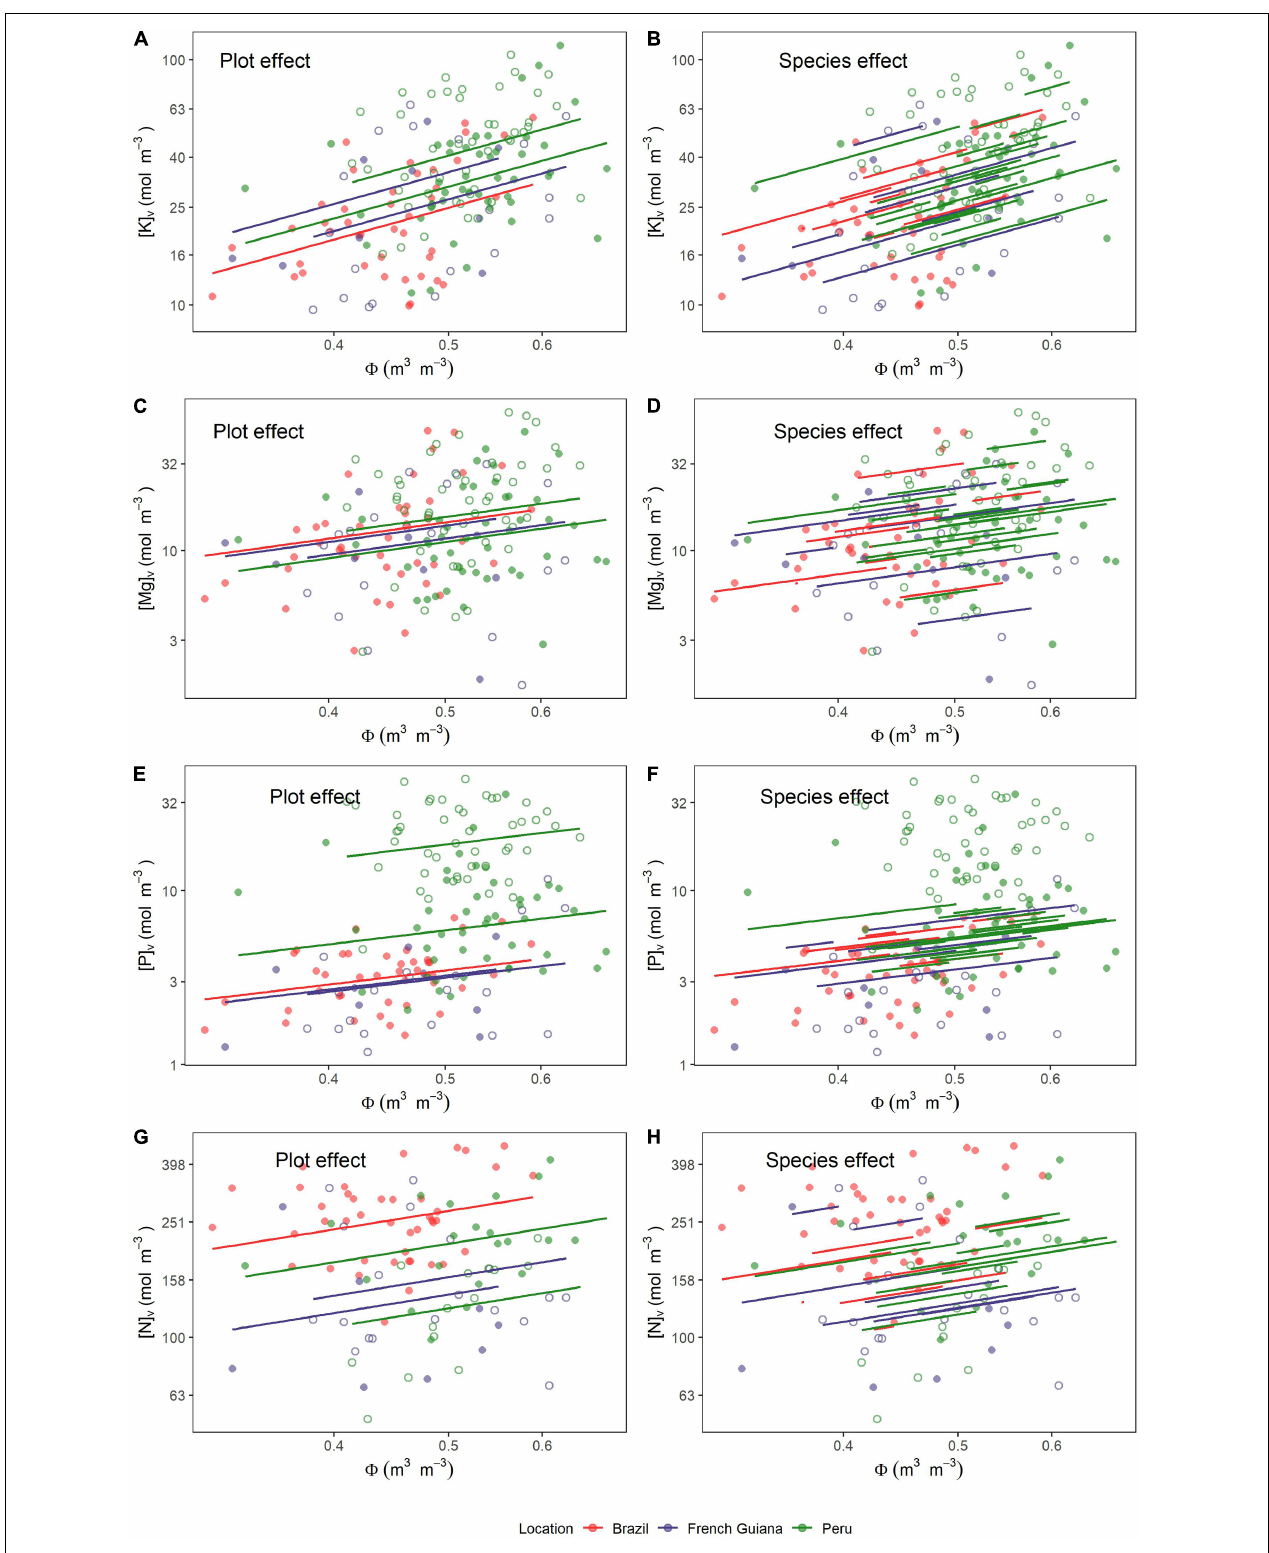
FIGURE 6 | Relationships between water content ( (cid:56) ) and nutrients on a volume basis ( (cid:50) v ). Lines are predicted estimates of mixed models for the species effect and plot effect (Equation 6) for (A,B) potassium, (C,D) magnesium, (E,F) phosphorus, and (G,H) nitrogen. Open and closed circles represent the plots within each